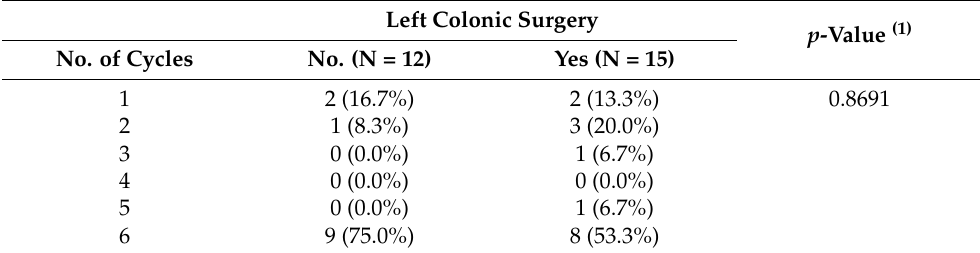
Table 3. Cycles of IP chemotherapy when patient underwent left colonic surgery.